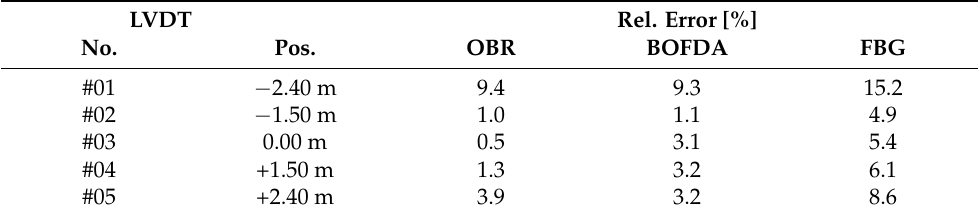
Table 4. Percentage errors of different sensing units at load step of 70 kN.